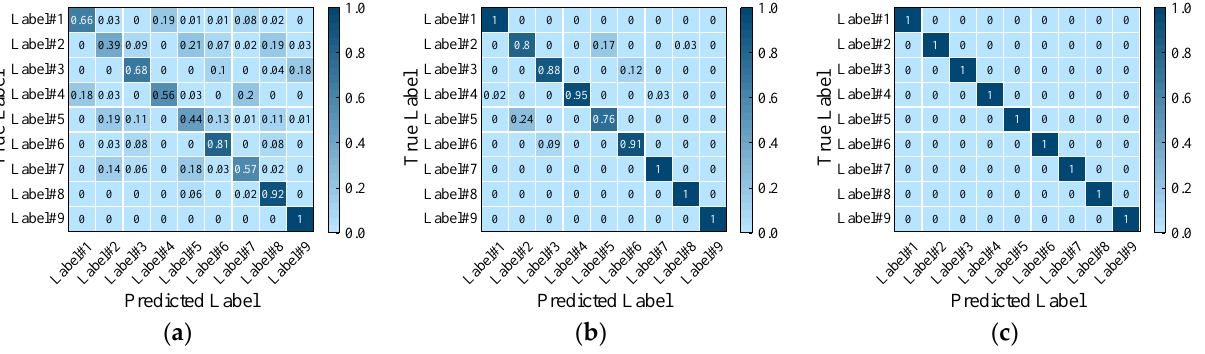
Figure 12. Confusion matrix of the target dataset: ( a ) time domain diagram; ( b ) frequency domain diagram; ( c ) time-frequency diagram.